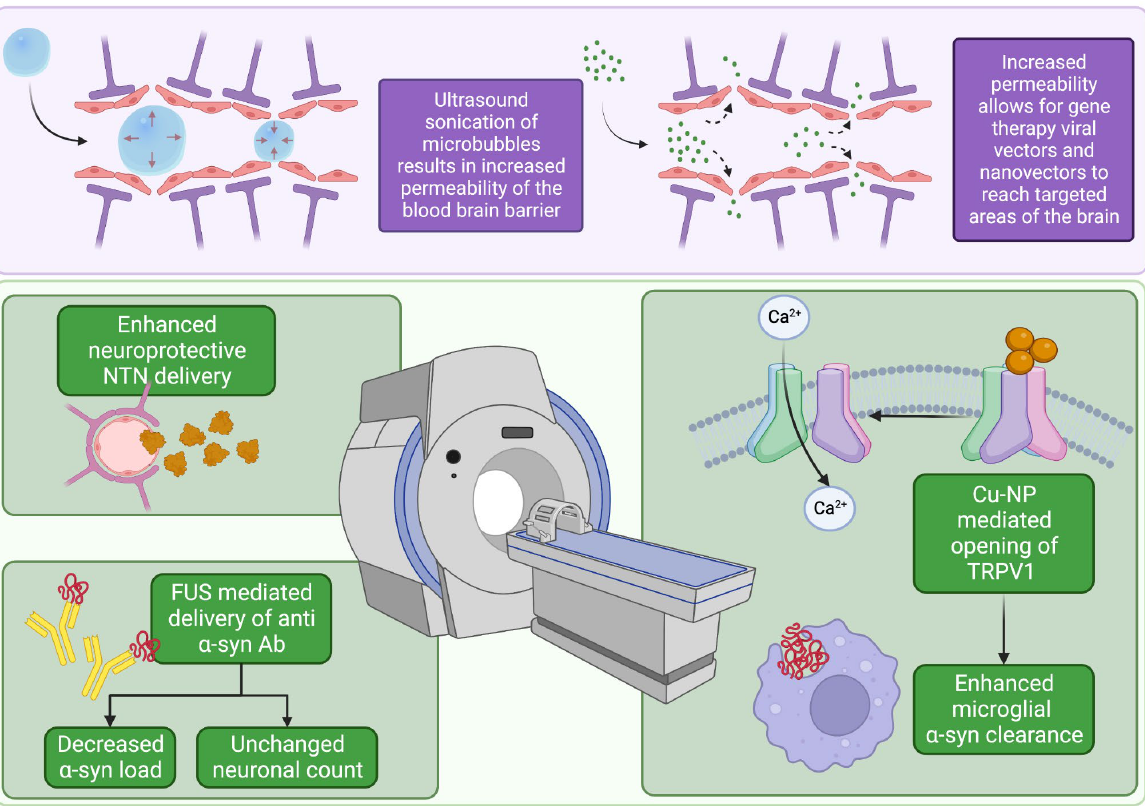
Figure 2. Summary of applications of focused ultrasound to synucleinopathies. Figure created with BioRender.com, accessed on 19 September 2022. BioRender.com, accessed on 19 September